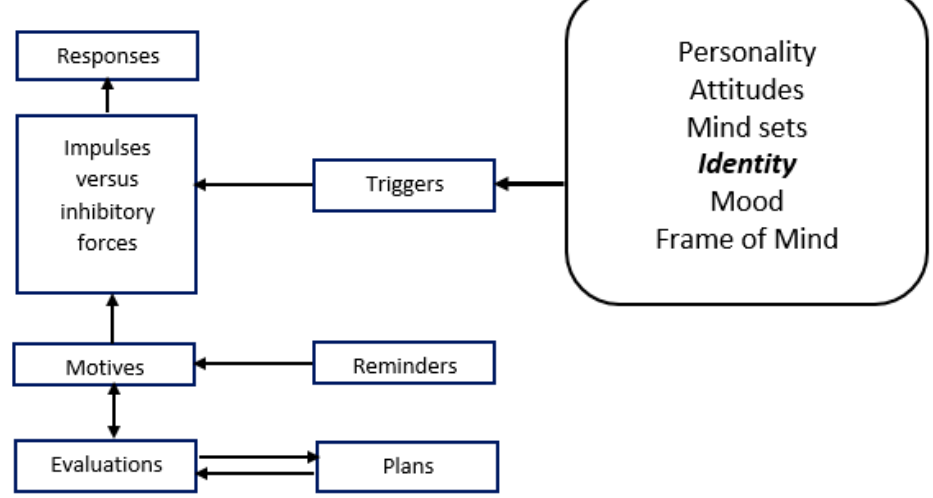
Figure 1. Theoretical framework of PRIME Theory